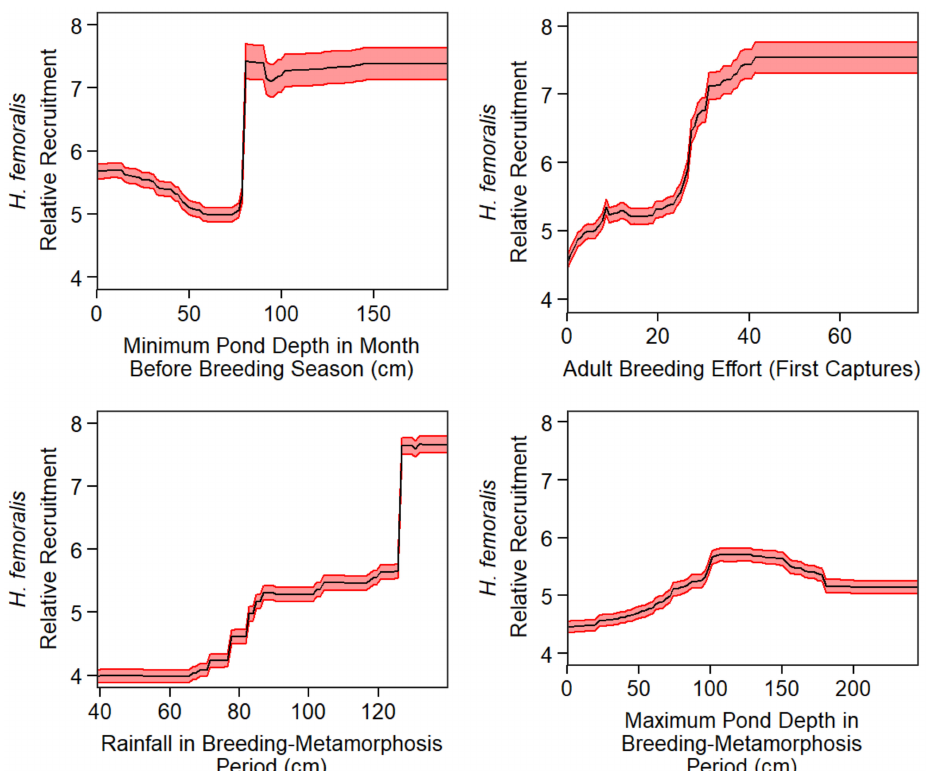
Figure 5. Influences of the four most important predictor variables (excluding pond ID) on rela- tive annual H. femoralis recruitment, Ocala National Forest, Marion County, Florida. Black lines and represent mean predictions using boosted regression trees (BRTs); red error ribbons represent standard